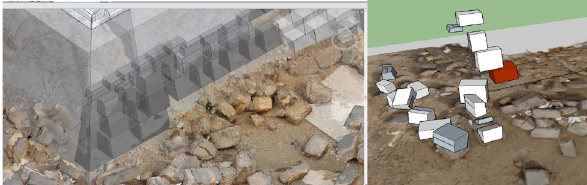
Figure 11: On the left side the re-positioning of the blocks collapsed in the S-W corner of the temple; on the right side the process of reverse-enginering.